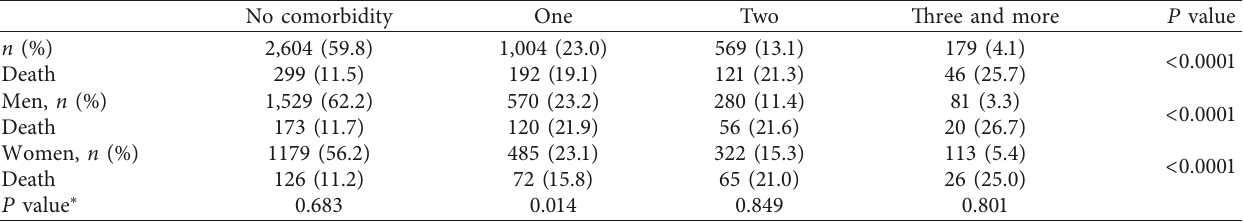
Table 4: Death rate according to the number of comorbidities and sex in hospitalized patients with positive real-time reverse-transcription polymerase chain reaction test results for COVID-19.